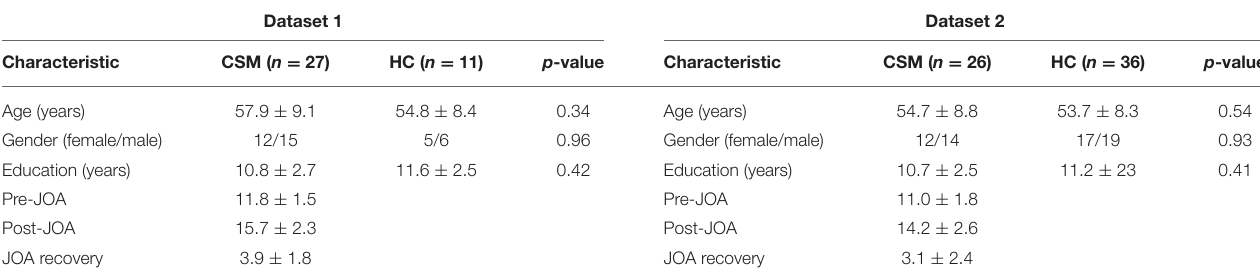
TABLE 1 | Demographic data and clinical assessment. Dataset 1 Dataset 2